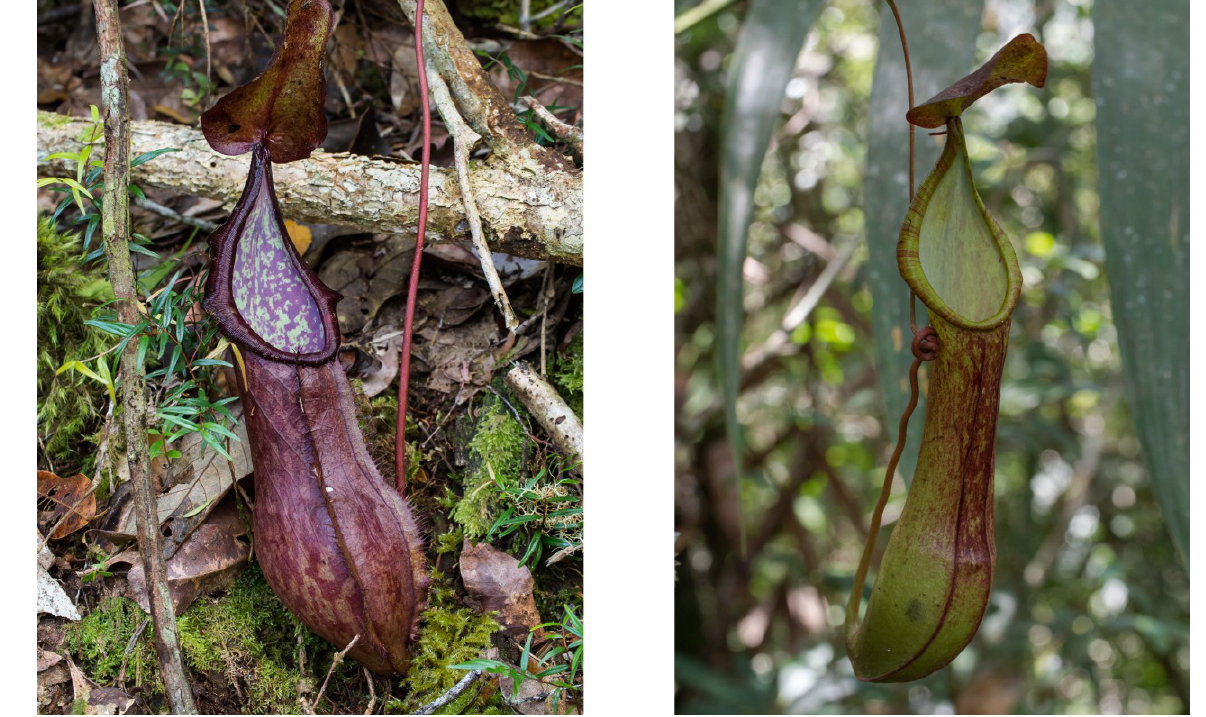
Figure A3. N. talaandig : Photos of a lower ( left ) and upper pitcher ( right ) taken at the type